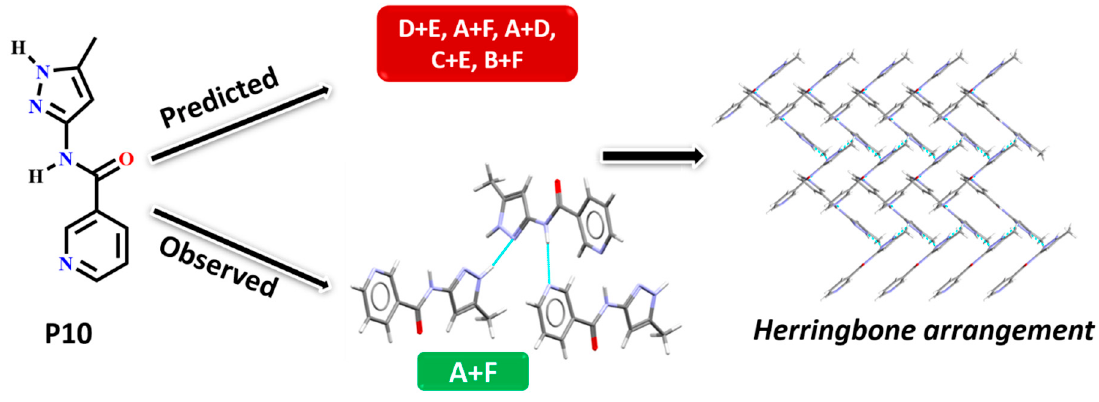
Figure 9. Synthon and packing observed in the crystal structure of P10 leading to herringbone-like structure.